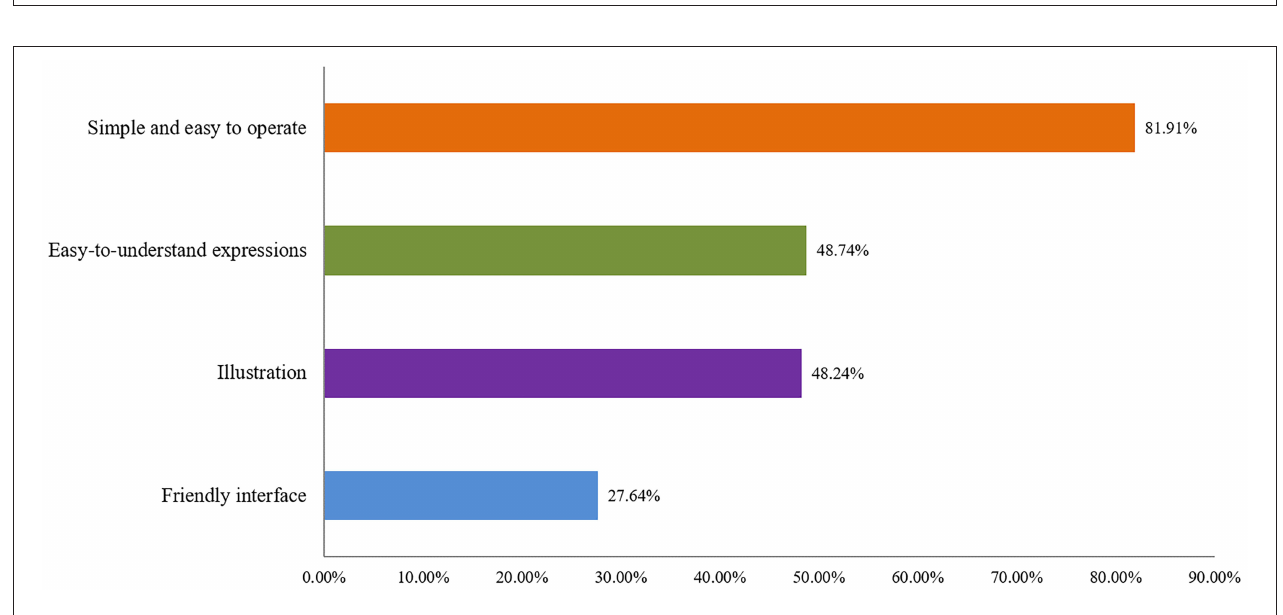
FIGURE 1 | Patients’ expectations of functional modules included in the Wechat applet for MTM.